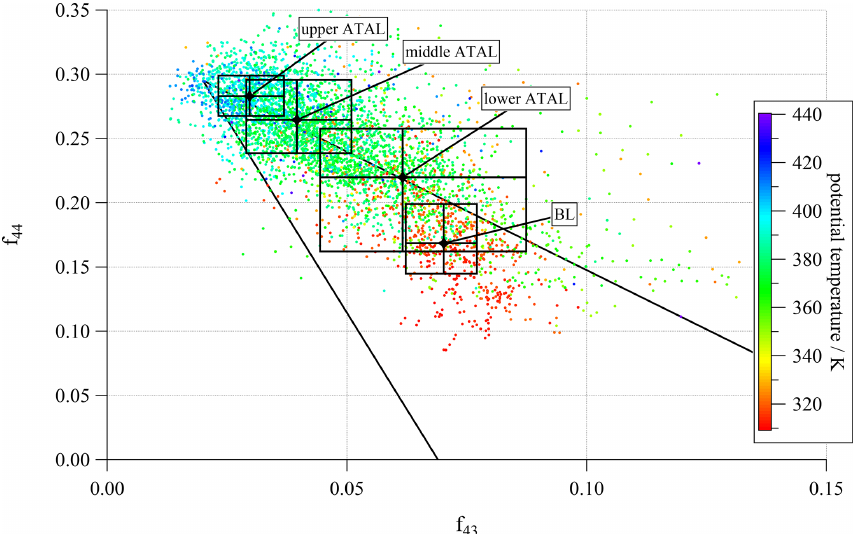
Figure 11. Graph showing the ratios f 44 vs. f 43 as indication for the degree of oxidation of the organic aerosol (color-coded with respect to potential temperature). Among all data points, where the total organic signal as well as the organic signals at m/z 43 and 44 are above the detection limit, we present the median values for the BL ( θ < 320K), the lower ATAL (355–370K), the middle ATAL (370–390K), and the upper ATAL (390–420K) in a box representing the corresponding 25th and 75th percentiles. For the median values, all data points where organics are above the detection limit are considered. Black lines show the triangular area according to the criteria introduced by Ng et al.